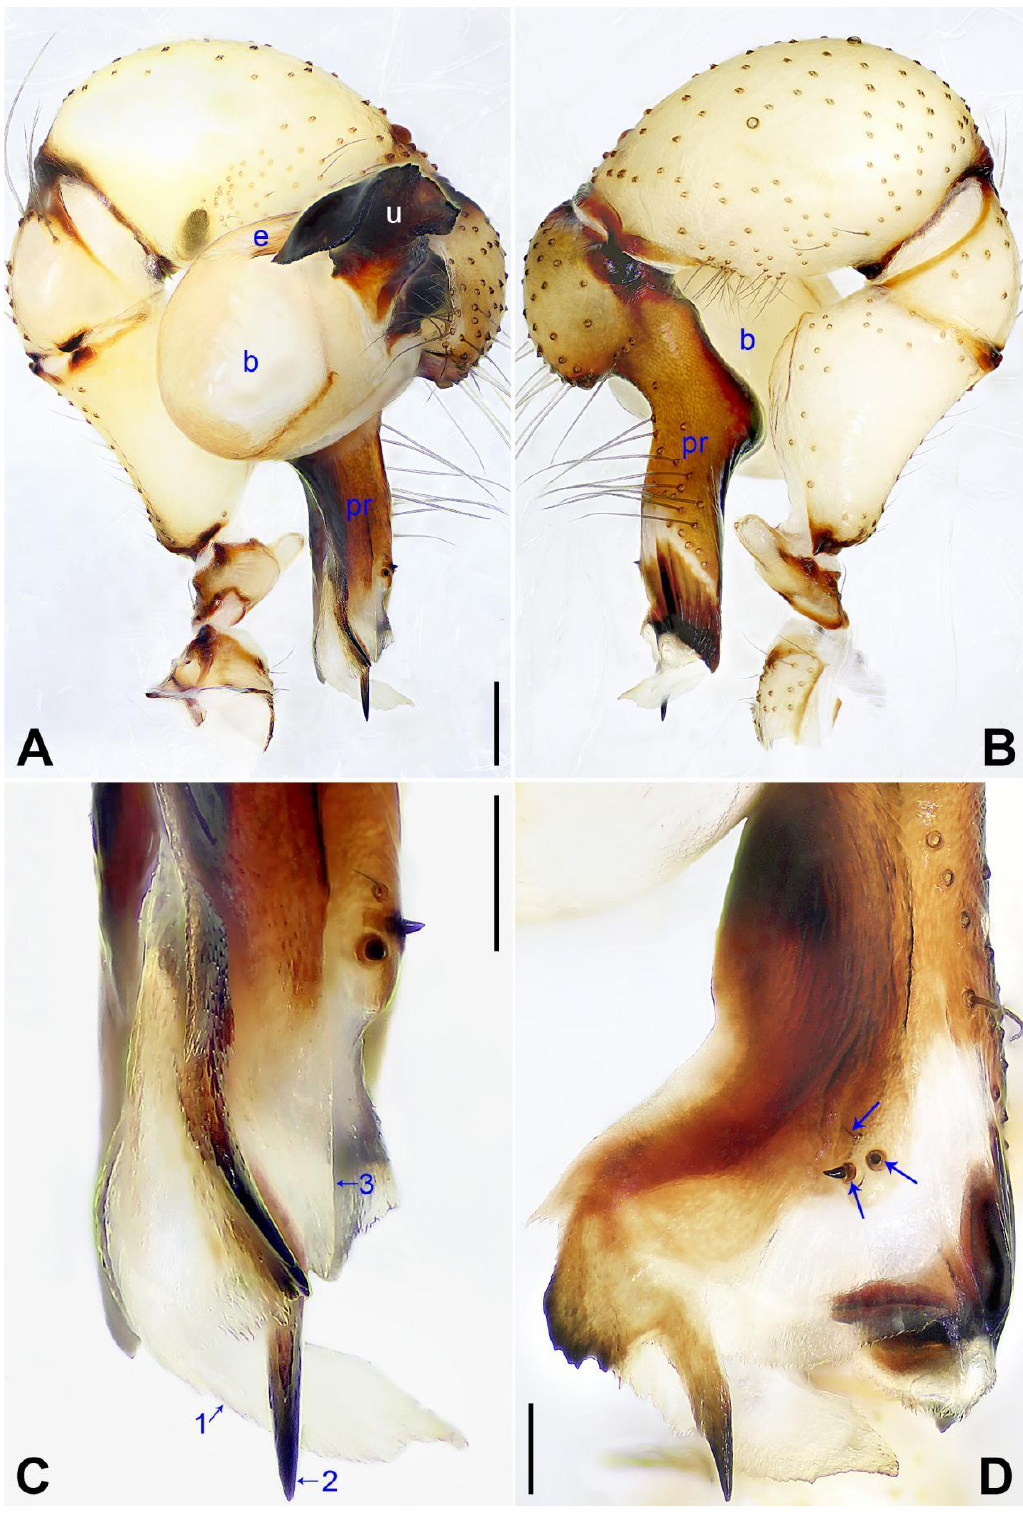
Figure 11. Pholcus wenshui sp. nov., holotype male: ( A ) pedipalp, prolateral view; ( B ) pedipalp, retrolateral view; ( C ) distal part of procursus, prolateral view (arrow 1 points at prolateral membranous process, arrow 2 points at spine-shaped distal apophysis, arrow 3 points at dorsal membranous lamella); ( D ) distal part of procursus, dorsal view (arrows point at dorsal spines). b = bulb, e = embolus, pr = procursus, u = uncus. Scale bars: ( A , B ) = 0.20 mm; ( C , D ) = 0.10 mm.